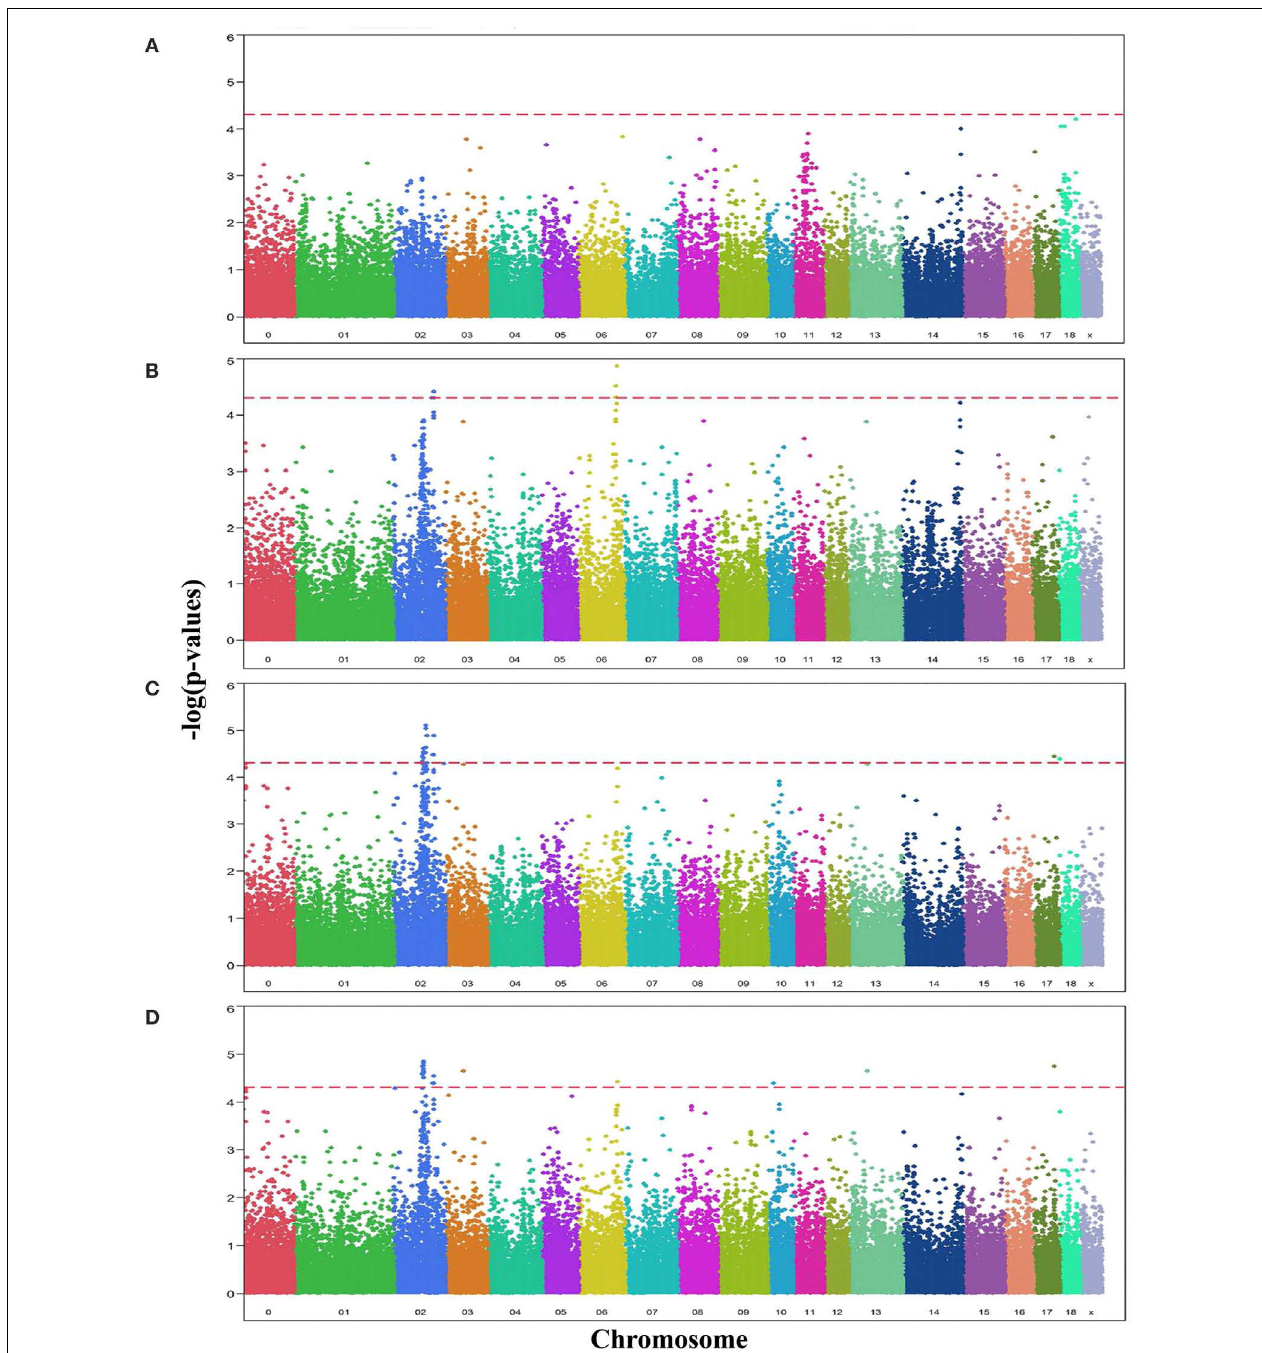
FIGUREA3 | Manhattan plots displaying the significance of associations of SNPs when using the SNPTBX5 c.54T > C as a fixed effect with OC lesion scores at (A) medial part of condylus humeri (CMH), (B) condylus medialis femoris (CMF), (C) distal epiphyseal cartilage of ulna (DEU), and